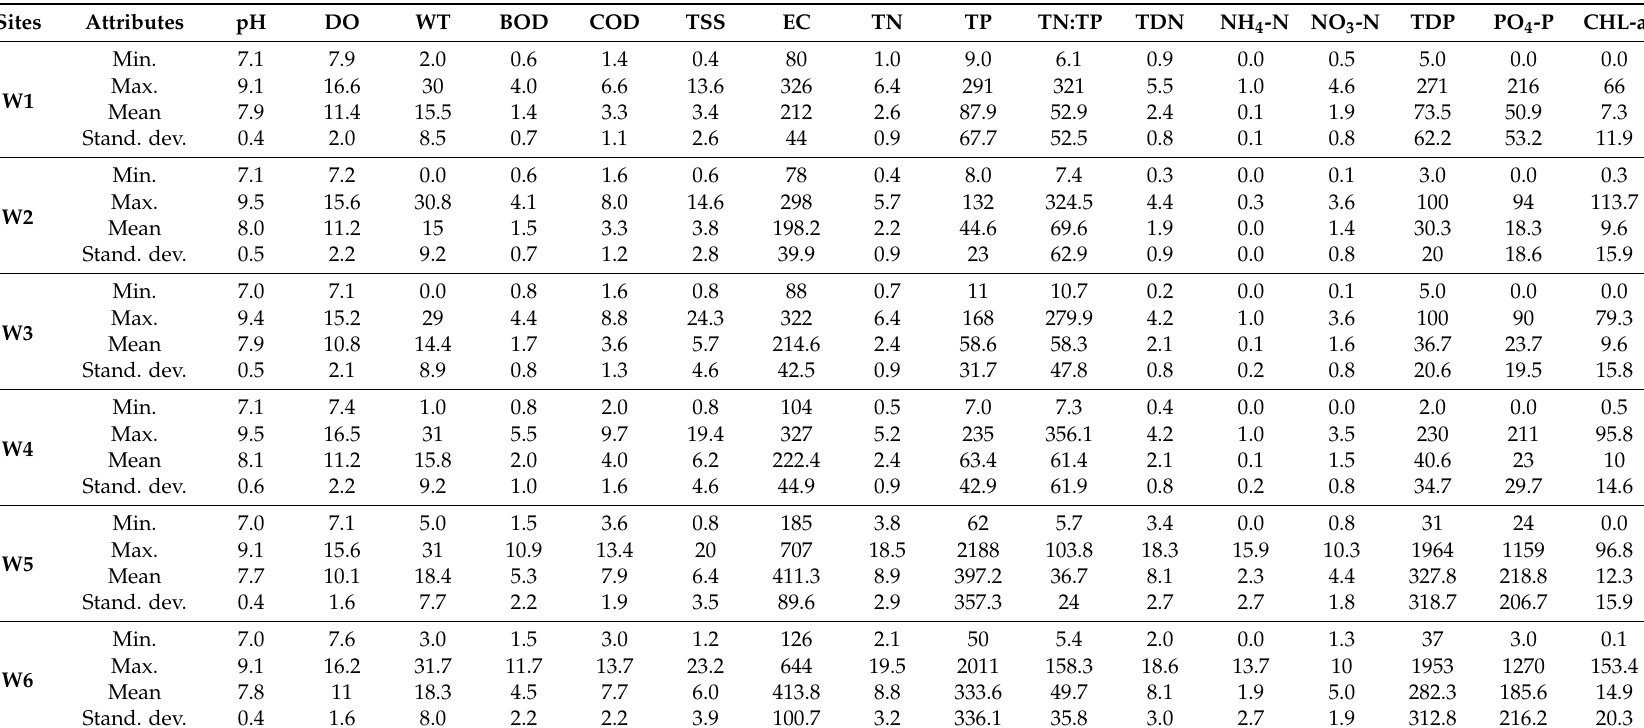
Table 2. Summary statistics of water chemistry factors in Gap Stream during